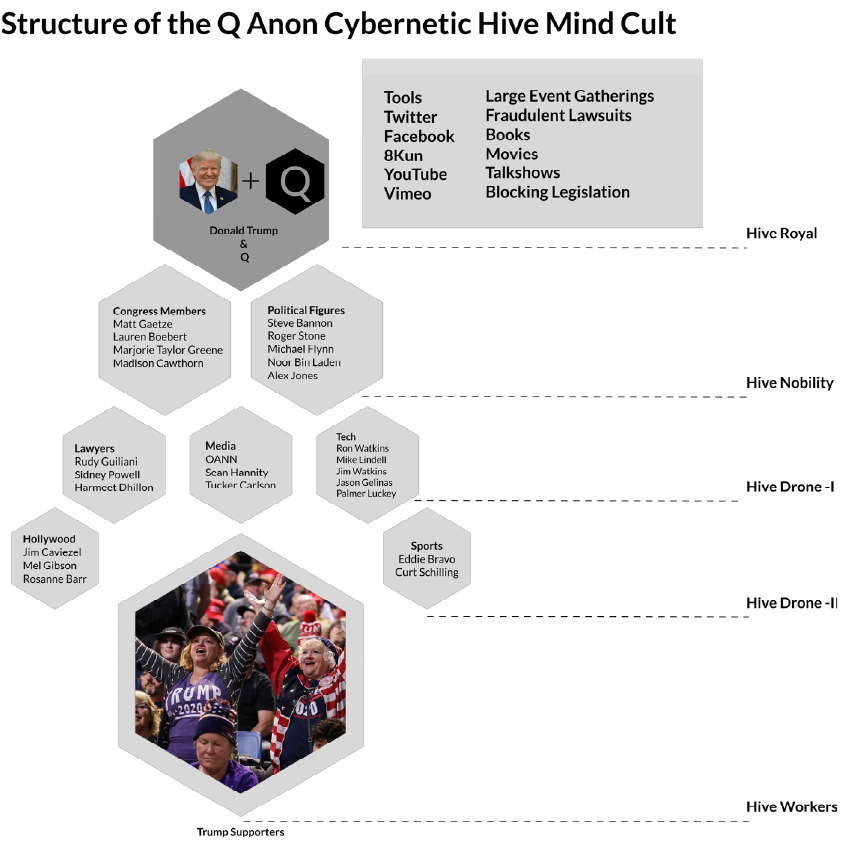
Figure 3. The hierarchical structure of QAnon, its puppet masters, their roles, and manipulation tools.